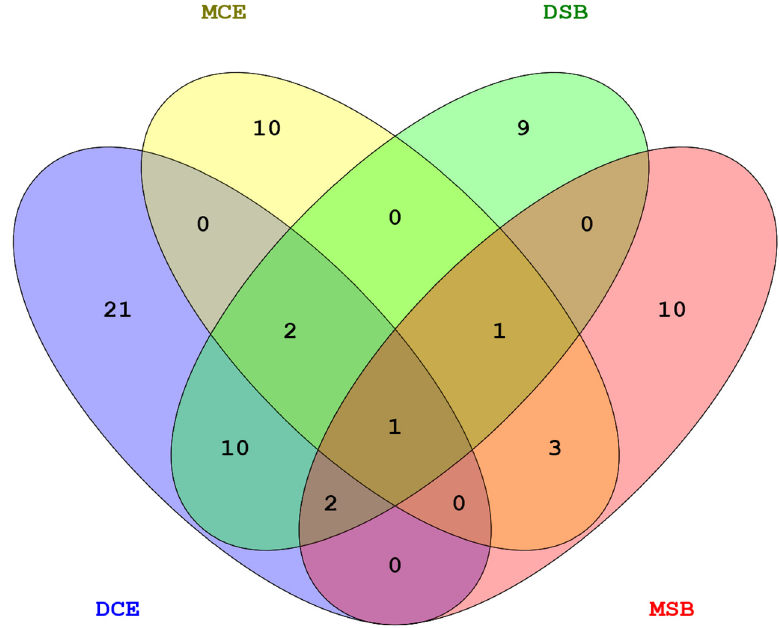
Figure 7. SNPs common amongst calving